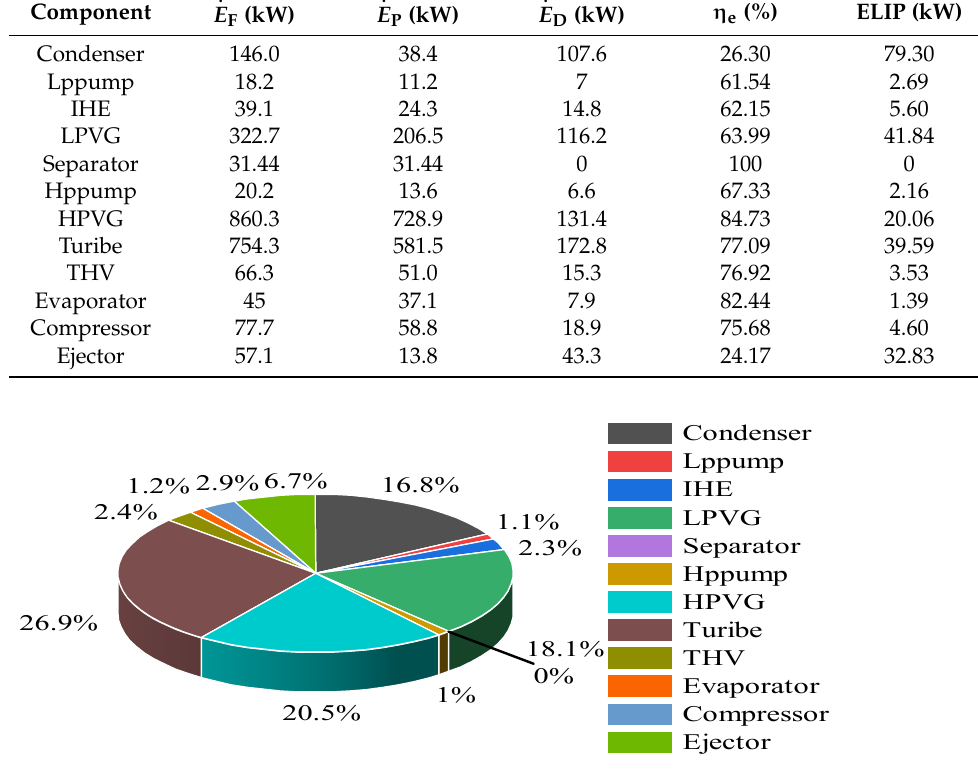
Figure 2. Exergy loss of system components.